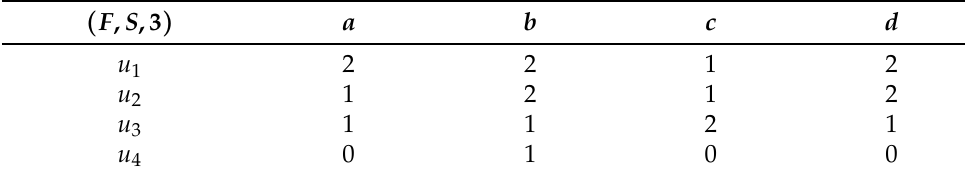
Table 2. The 3-Soft Set of ( F , S ,3 ) .